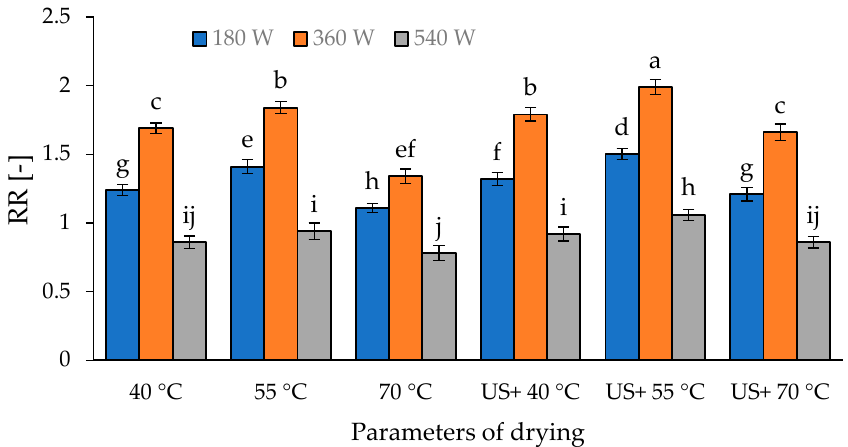
Figure 5. Effects of US pretreatment, MW power, and air temperature during drying on rehydration ratio (RR) in hawthorn. Data followed by different letters (a–j) in each column are significantly different at p < 0.01. Columns with the same letters are not significantly different.